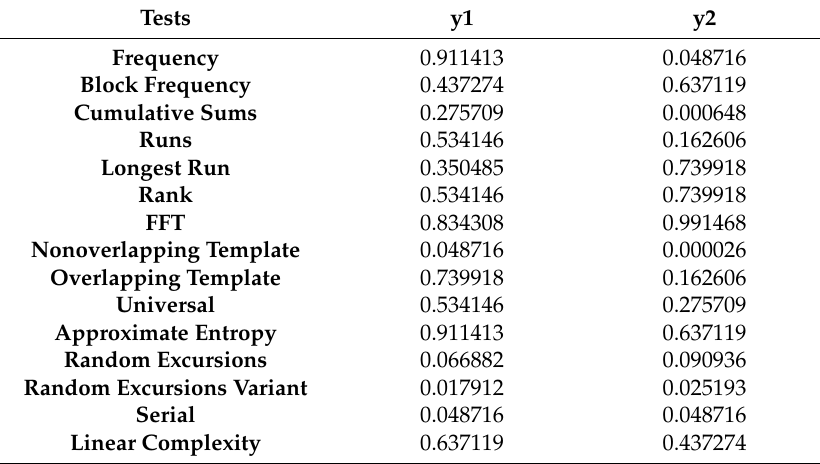
Table 1. Randomness test.